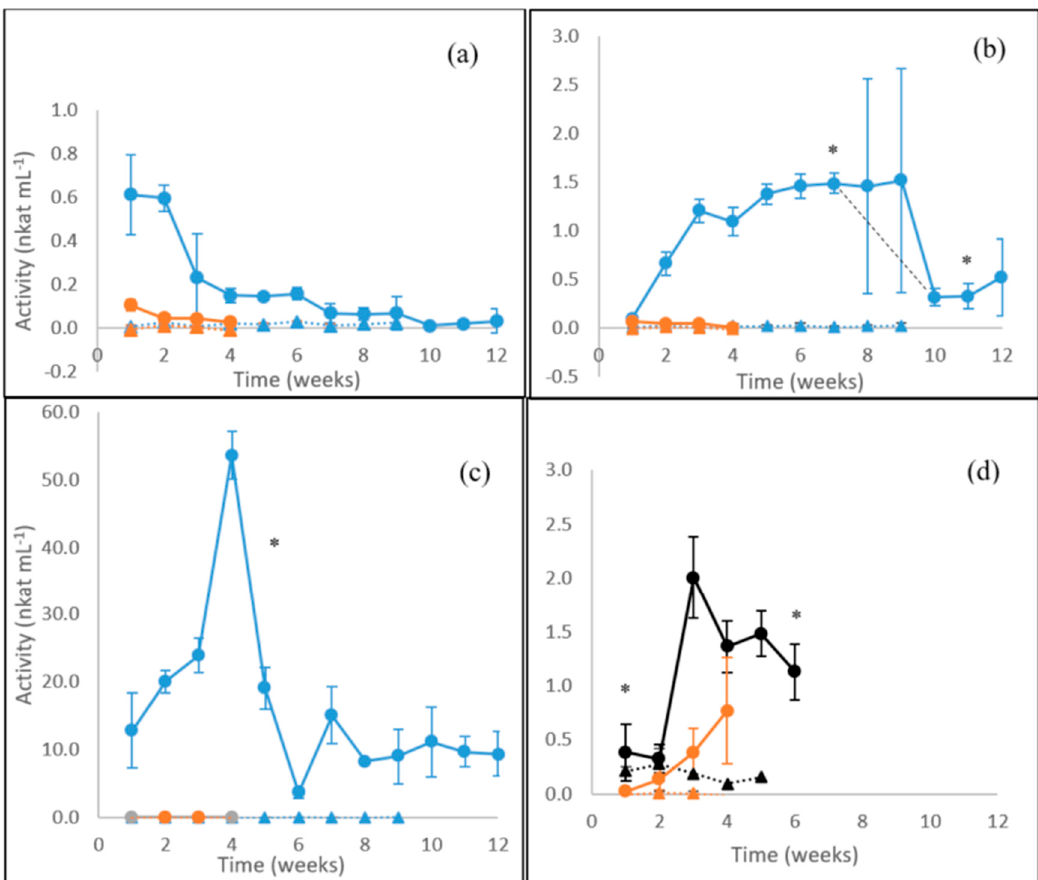
Figure 3. β -glucosidase activities produced by ( a ) the WR fungus P. radiata ; ( b ) the BR fungus F. pinicola ; ( c ) the GR fungus S. commune ; and ( d ) the LDF species C. cinerea . Fungal cultivations on birch wood (blue line with spheres), on barley straw (black line with spheres) and on liquid ME medium (orange line with spheres). Values from control incubations of birch wood (blue triangles), barley straw (black triangles) and liquid ME medium (orange triangles) without fungi are included. Mean value ( n = 3) is presented at each week time point. Bars indicate the standard error. * statistically significant changes between time points. Notice different scales in the y axis. For information on the fungi, see Table 1.